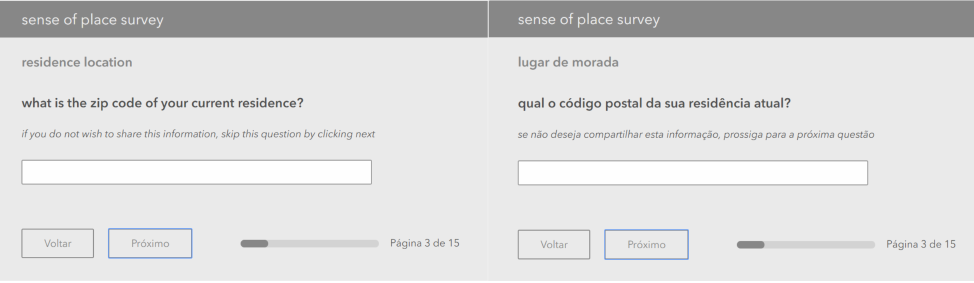
Figure 5: Residence location question.